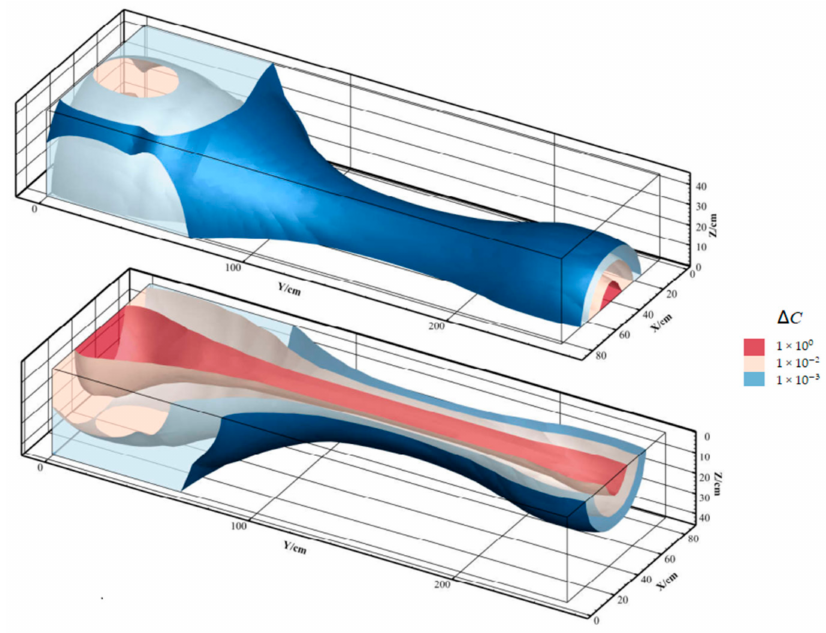
Figure 9. The contribution factor distribution for the IRI-TUB benchmark.